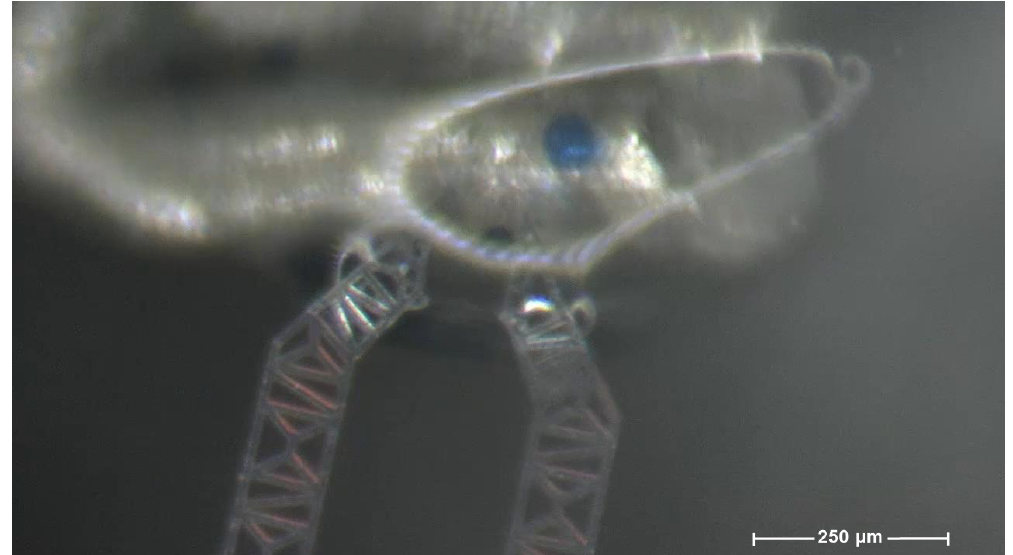
Figure 8. A frame from the sequence illustrated in the Figure 9